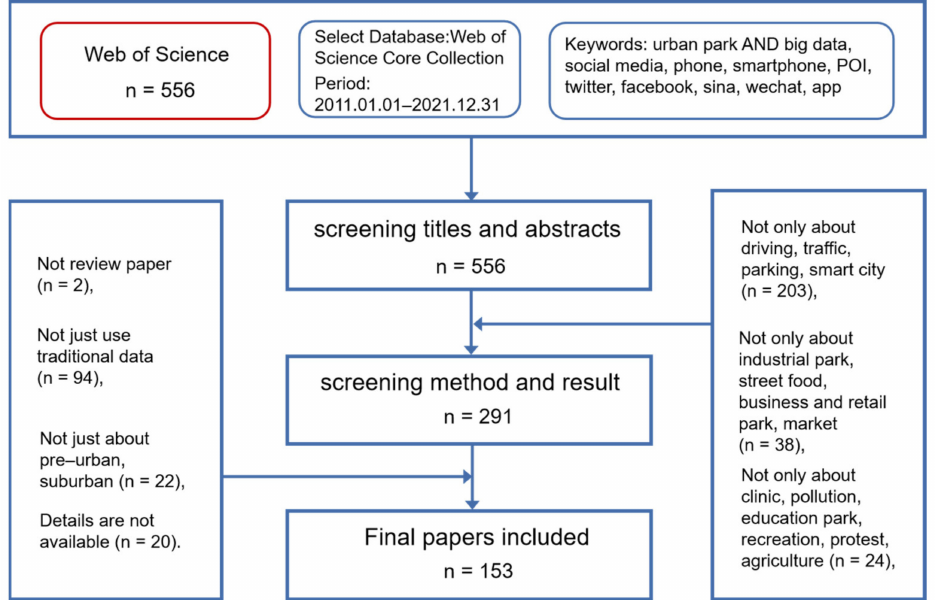
Figure 1. Flowchart of screening effective urban park-related